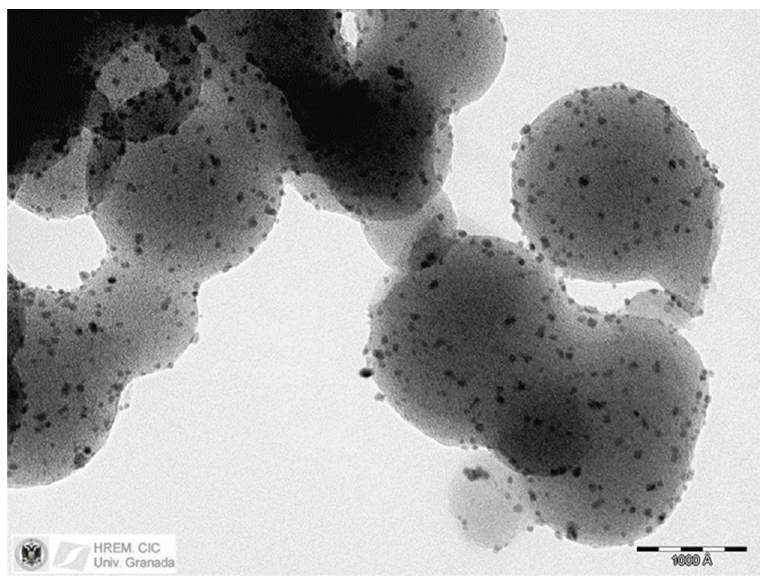
Figure 3. Highly dispersed Mo nanoparticles on carbon xerogel S10 (RF + CTAB cationic surfactant + t-butanol) after carbonization at 900 °C.